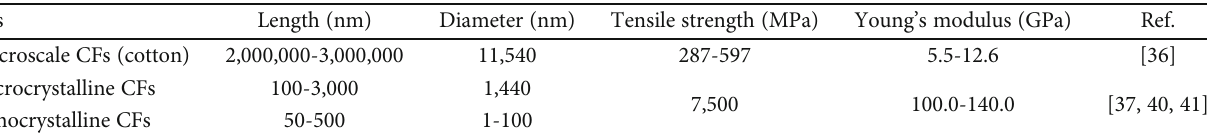
Table 2: Performance of CFs and commonly used fi bers.